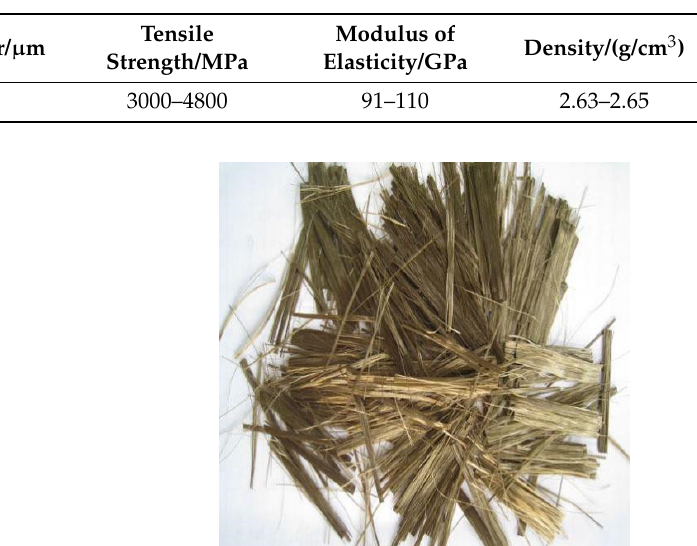
Table 3. Basalt fiber composition.